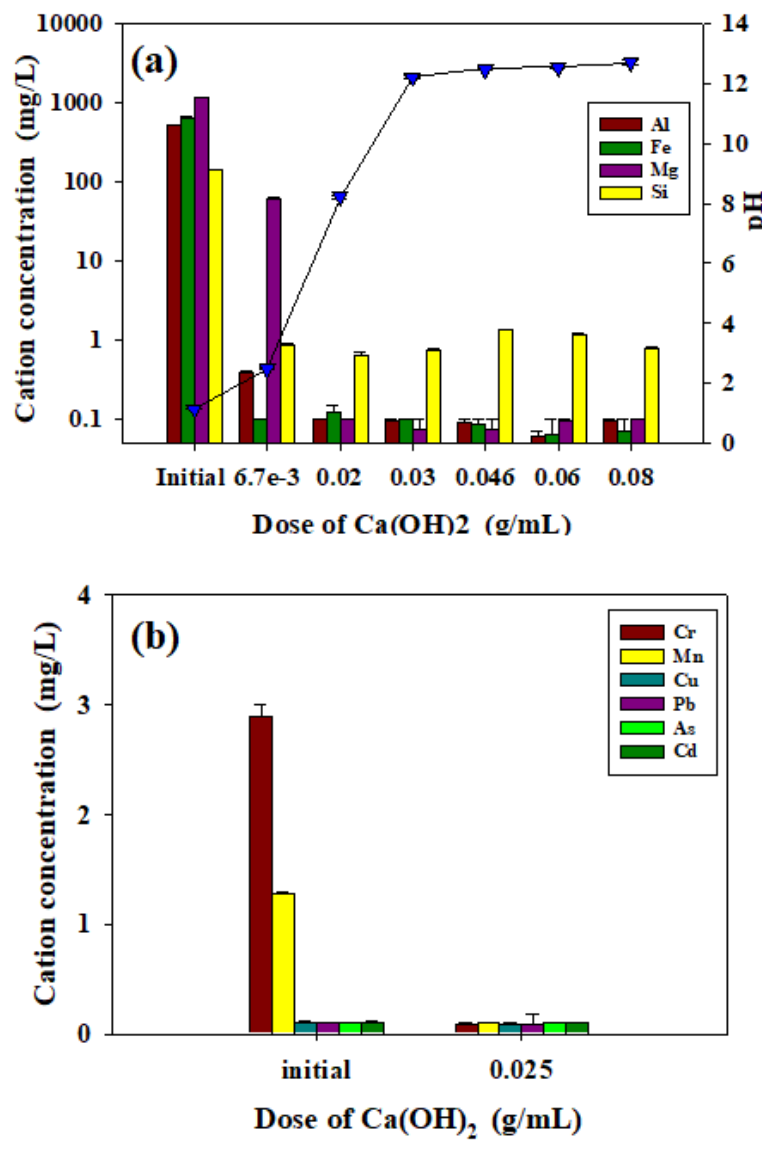
Figure 6. ( a ) Determination of optimum conditions and pH changes for the removal of metal ions by Ca(OH) 2 dose in washing wastewater after 0.15 M oxalic acid treatment of HBT- 133 Cs contaminated clay minerals and ( b ) removal of heavy metal. (n = 2, mean ± standard error of mean).